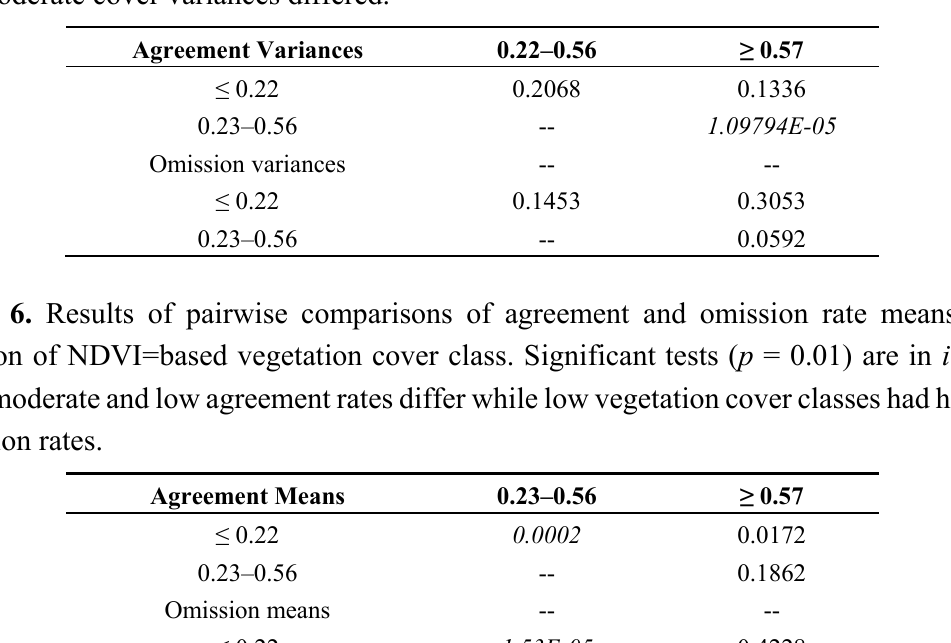
Table 5. The variances of agreement and omission rates given all unobscured EDEN gages/all study dates were first compared to ensure that appropriate statistical means comparisons were conducted. Statistically significant tests ( p = 0.01) are in italics . Only high and moderate cover variances differed.